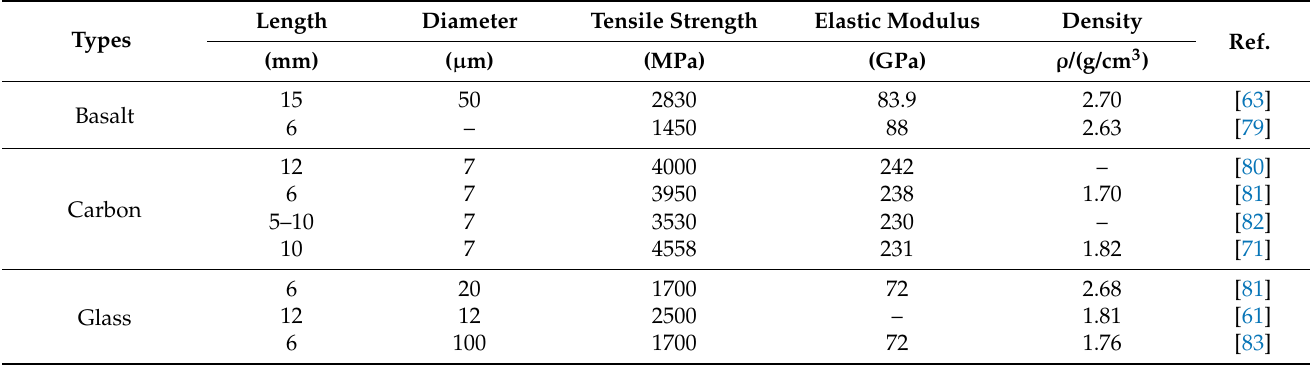
Table 3. Basic mechanical properties of typical inorganic fibers.